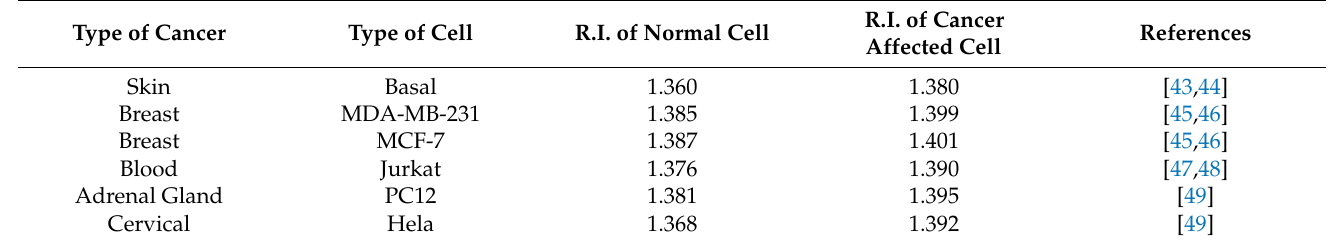
Table 1. The difference in refractive index among normal and cancer affected cells.